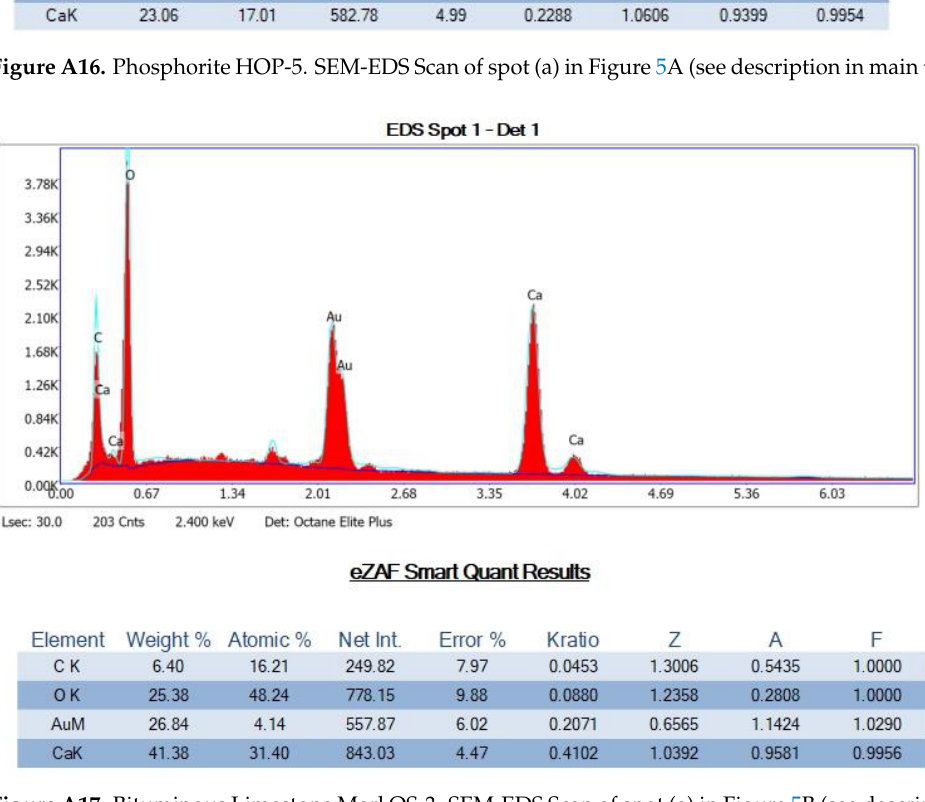
Figure A17. Bituminous Limestone Marl OS-3. SEM-EDS Scan of spot (a) in Figure 5B (see description in main text).